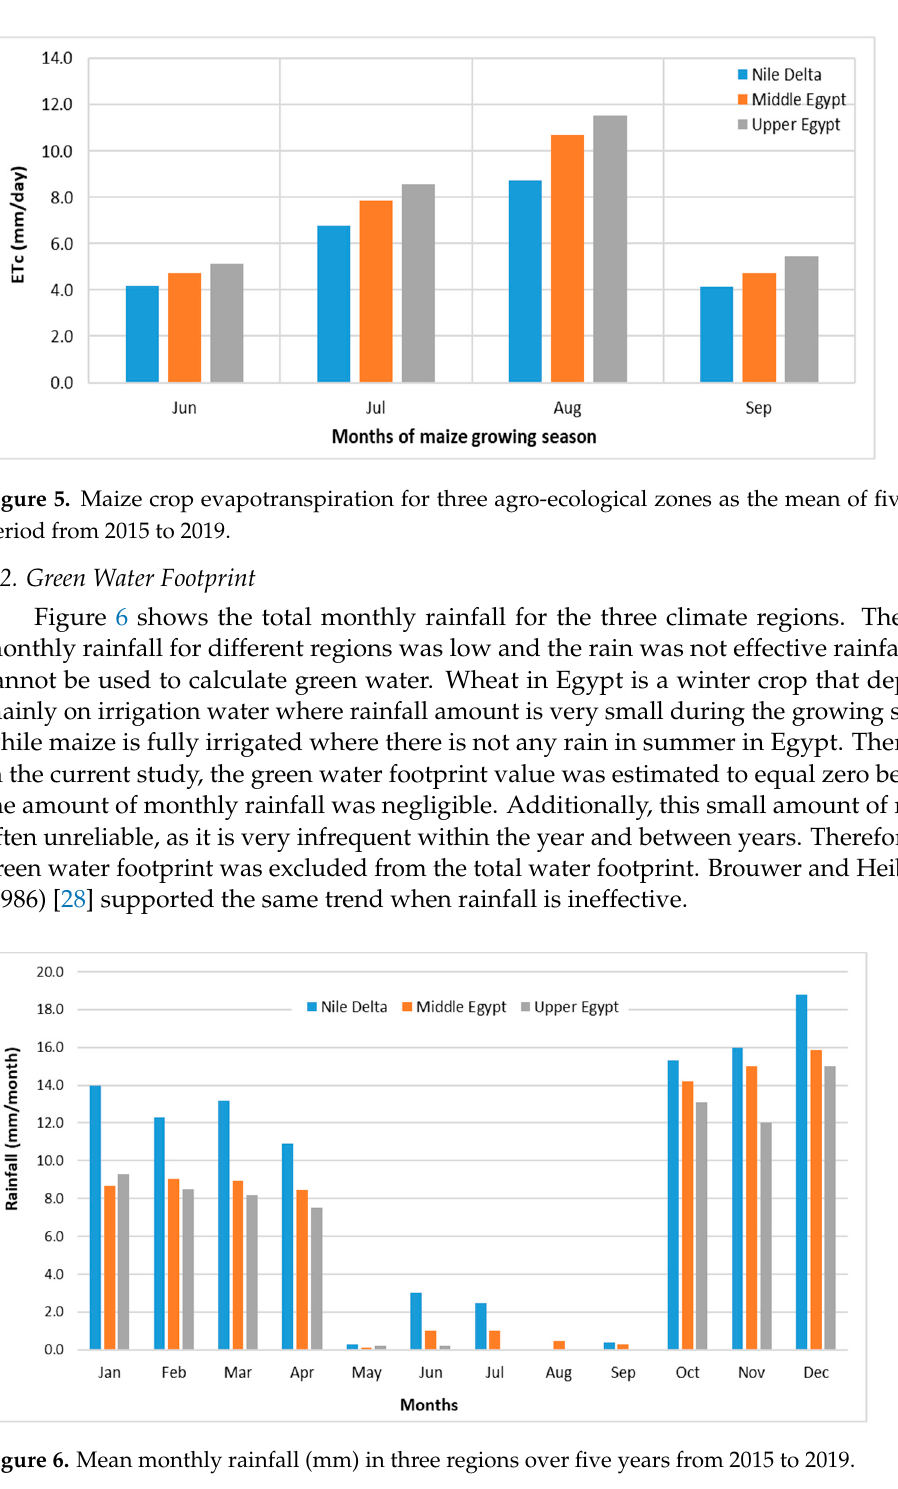
Figure 4. Wheat crop evapotranspiration for the three agro-ecological zones as the mean of a five- year period from 2015 to 2019.